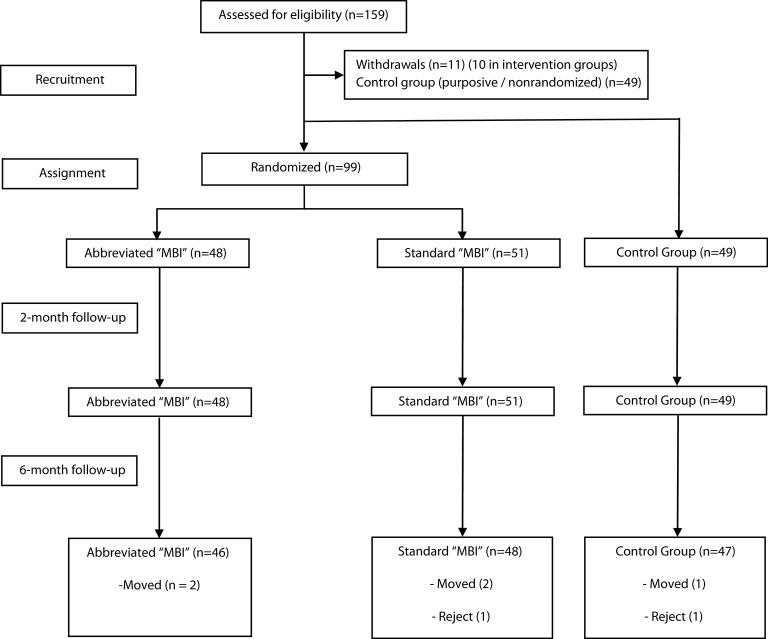
Study flowchart.